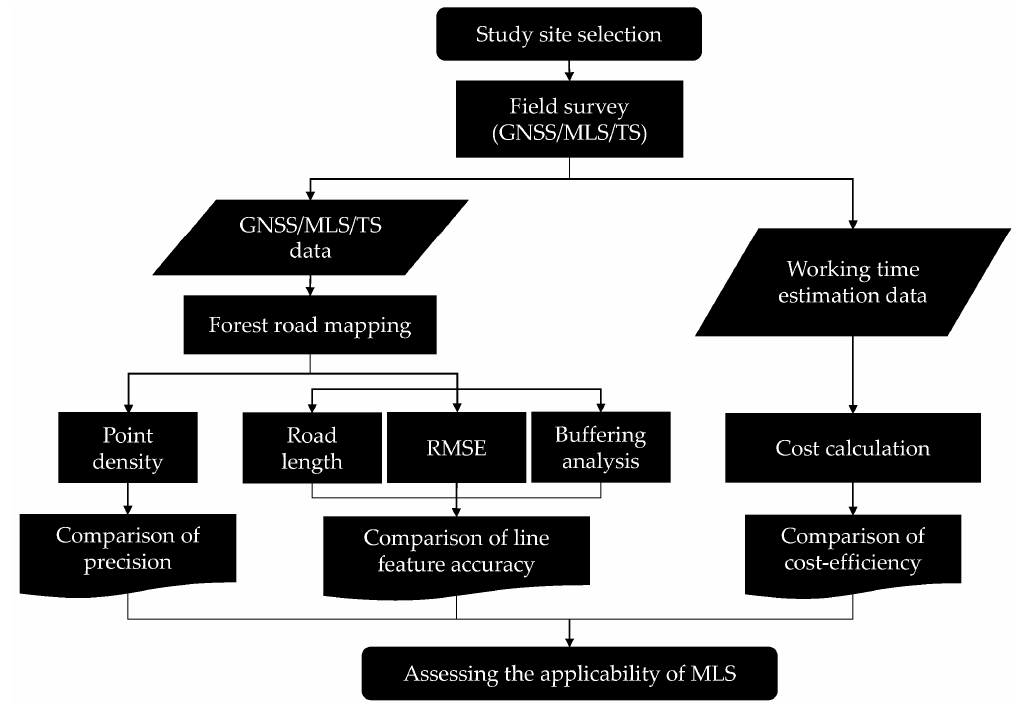
Figure 1. Flowchart displaying an approach of the study.